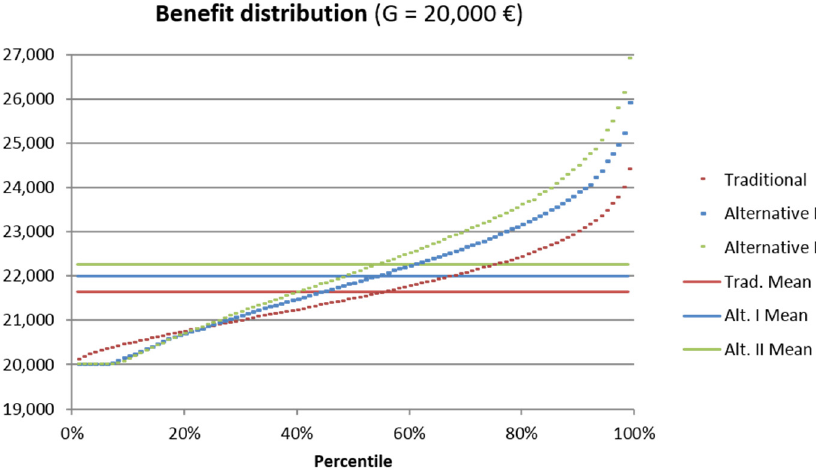
Figure 3. Benefit distribution of products with the same PVFP and the same SCR mkt , based on the traditional product with q = 5% .